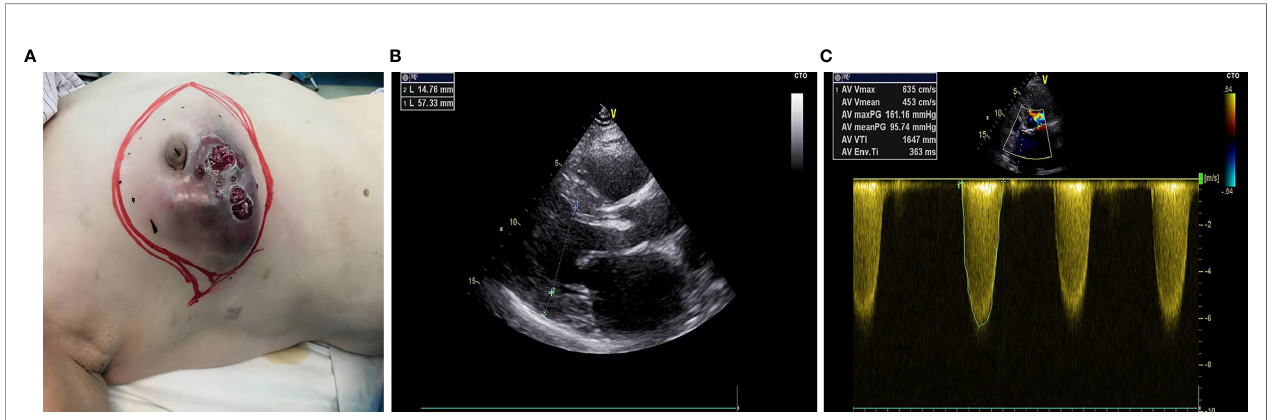
FIGURE 1 | Preoperative information of the patient. (A) Appearance of the breast. (B) Two-dimensional echocardiography: the enlarged left ventricle and thickened left ventricular wall. (C) M-mode echocardiography: accelerated systolic forward fl ow through aortic valve, increased maximum and average aortic transvalvular pressure